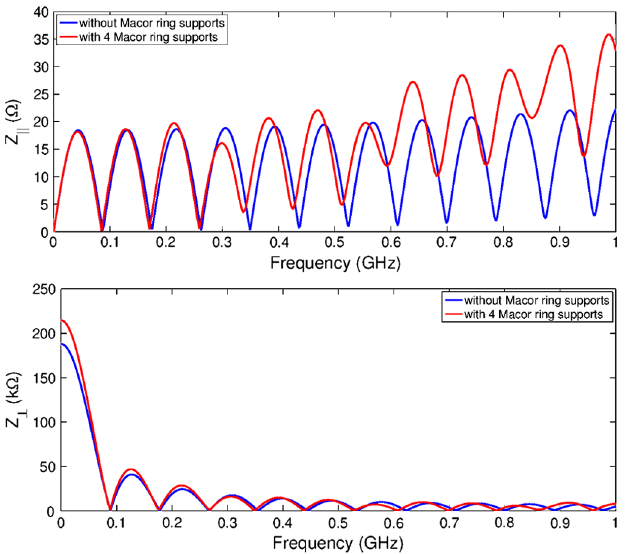
FIG. 13. Longitudinal (top) and transverse (bottom) beam coupling impedance for half-moon electrode striplines with and without Macor rings, simulated with CST PS, for ideal 50 Ω feedthroughs.